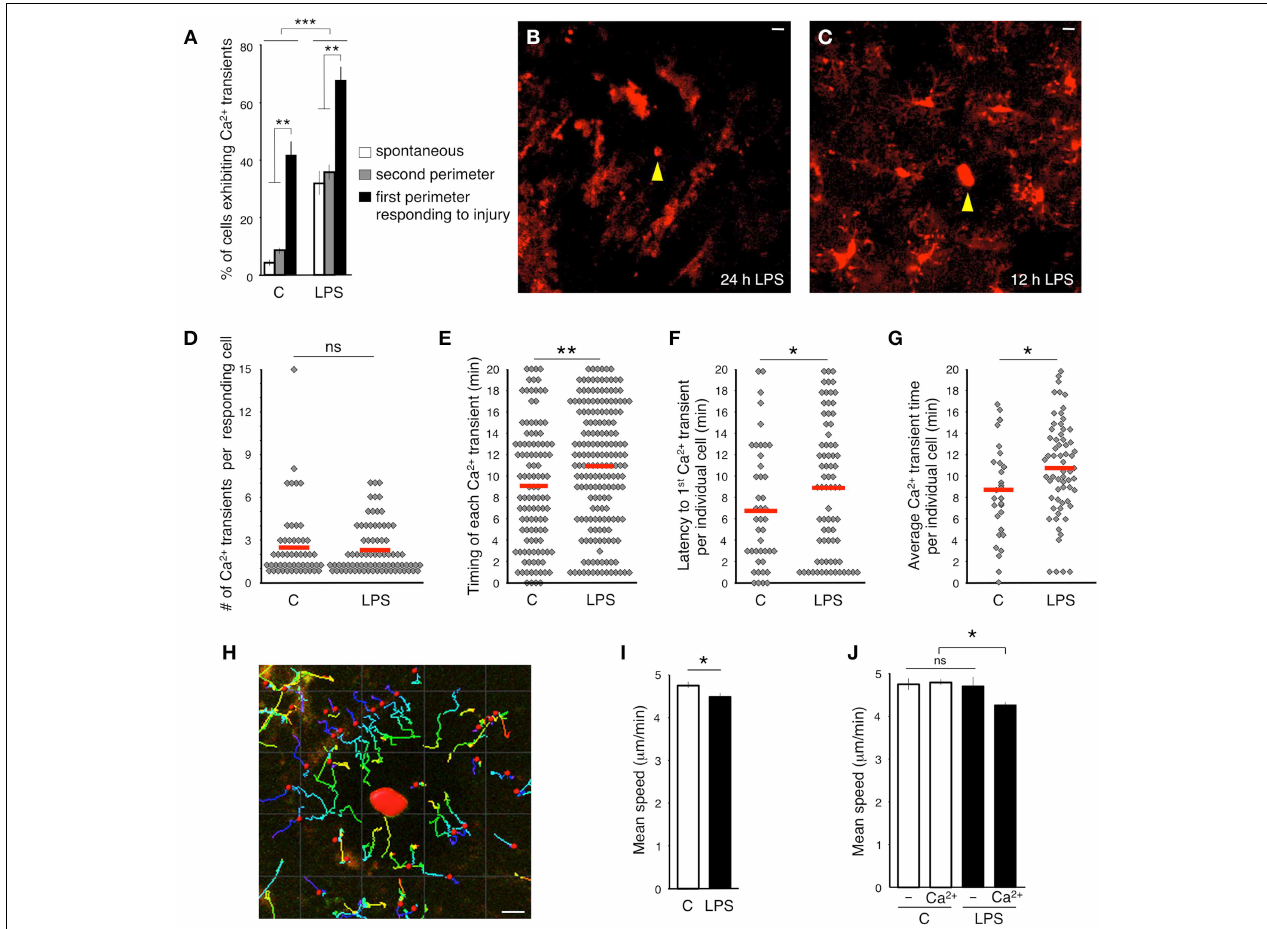
graph illustrating the distribution of the number of Ca 2 + transients in responding cells during the entire imaging session. No significant (ns) differences were detected between control and LPS-primed cells. The red lines indicate the means. (E) Time between injury and each individual Ca 2 + transient emerging in responding cells. (F) Latency between the time of injury and the first Ca 2 + transient observed in a specific responding cell. (G) Latency from the time of injury to the average emergence time of all Ca 2 + transients detected per one responding cell. (H) An example of tracking the microglial process movement with Imaris software. The injury site is marked in red. (I) Average speed of process protrusion was significantly reduced in LPS-primed microglia. (J) No process speed difference was found between LPS-primed microglia not exhibiting Ca 2 + transients and control cells. In contrast, the mean process speed was significantly reduced in LPS-primed Ca 2 + -positive microglia. Bar graphs are mean ± SEM from n = 3 mice ( > 10 cells per mouse), ( > 18 cells per mouse in I–J ). * p < 0 . 05 , ** p < 0 . 005 by Student’s t -test, *** p < 0 . 02 by a 2 × 3 factor ANOVA (treatments × groups). Scale bars: 10 µ